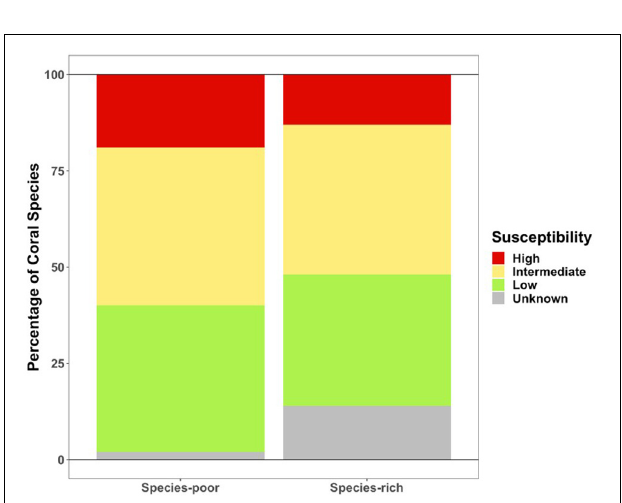
FIGURE 8 | Coral cover composition of susceptibility classifications in the endemic zone in pre-outbreak surveys.